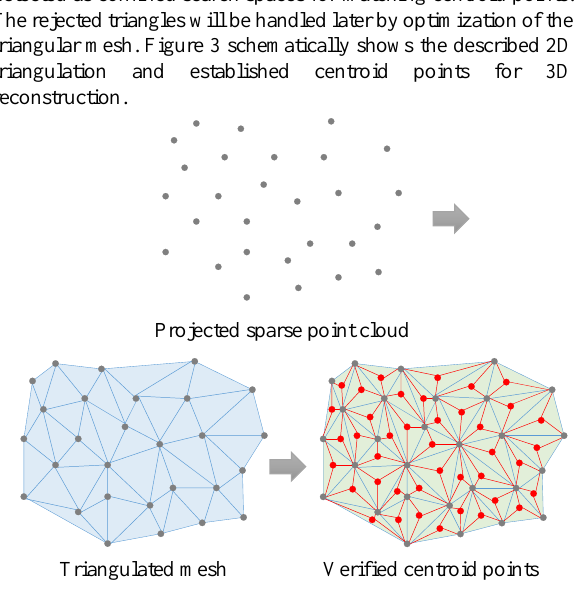
Figure 3: 2D triangulation and identification of candidate points for 3D reconstruction